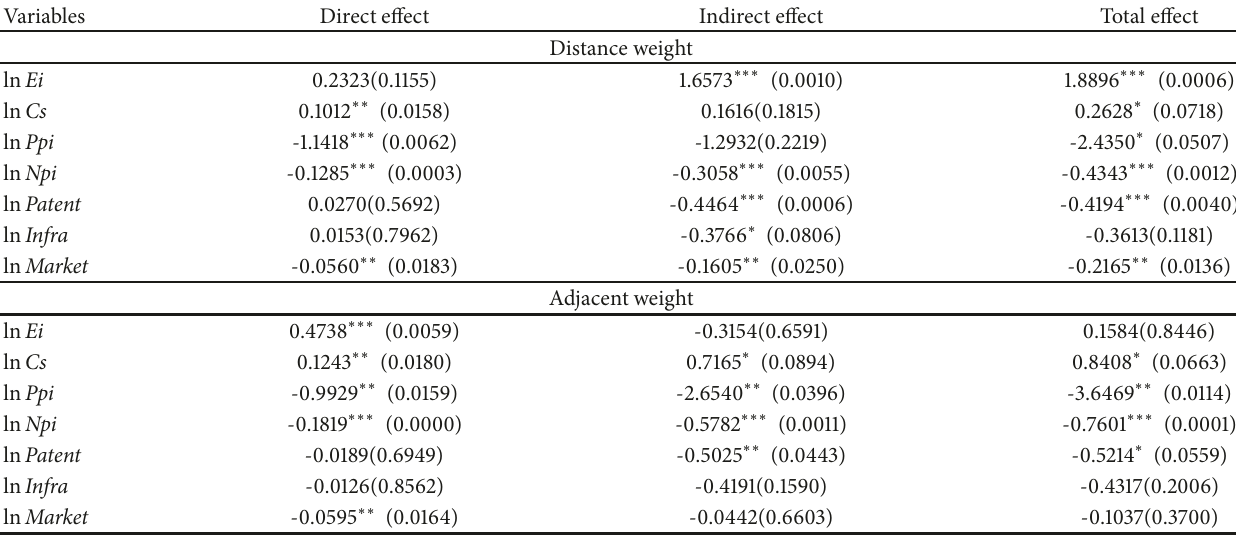
Table 6: Decomposition estimates of the direct, indirect, and total